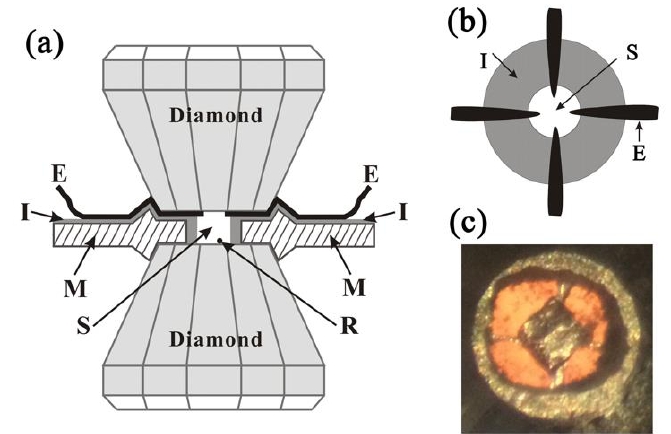
Figure 1. Sketch of the sample inside a diamond anvil cell (DAC) for electrical impedance spectroscopy. E: electrode, I: electrical insulation layer, M: metal gasket, S: sample chamber, and R: ruby sphere for pressure calibration. ( a ) Side view of the cell sketch; ( b ) top view of the gasket ring and electrodes; ( c ) sample in the cell under a microscope.